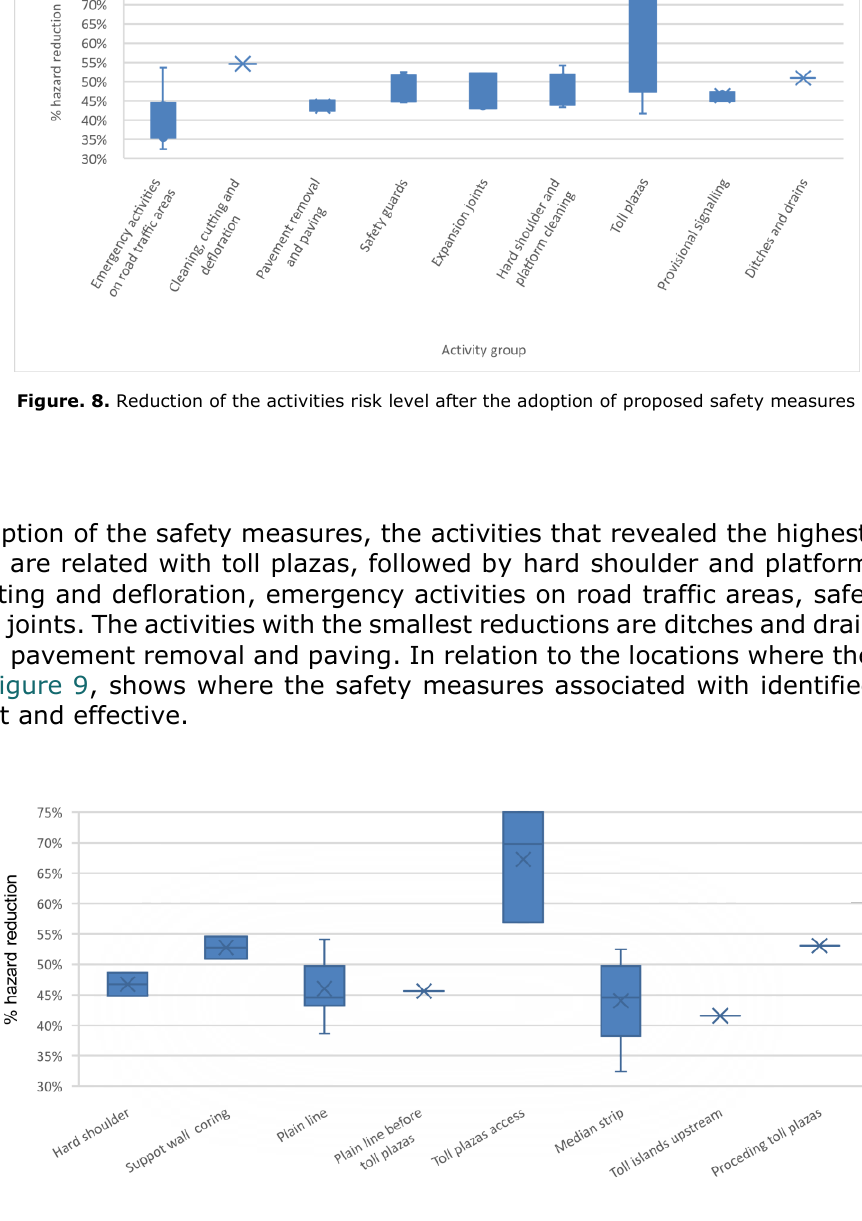
Figure. 9. Reduction of the activities risk level after the adoption of proposed safety